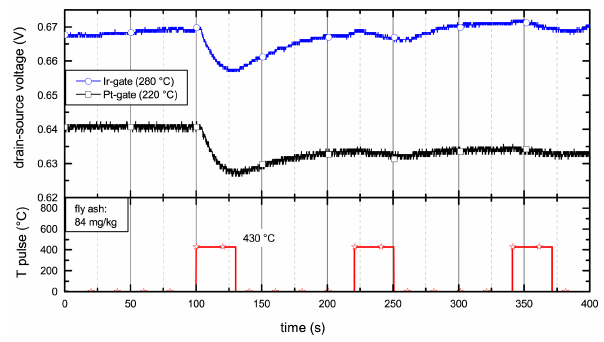
Figure 10. Top: sensor responses of Pt- and Ir-gate SiC-FETs at 220 and 280 ◦ C respectively. Bottom: heating pulses up to 430 ◦ C.